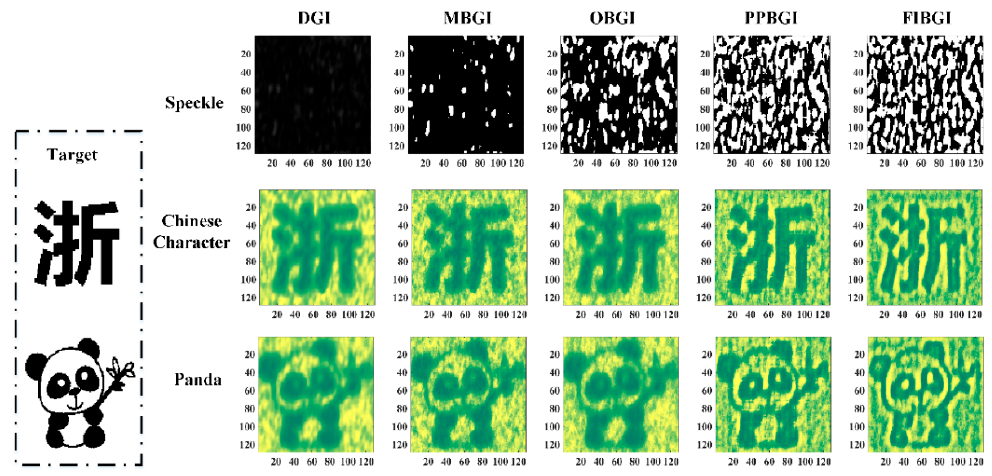
Figure 4. The binarized speckle distributions and the reconstruction results with different methods. The total number of measurements is 10,000.